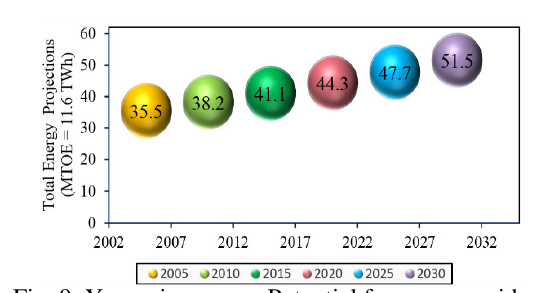
Fig. 9: Year-wise energy Potential from crop residues